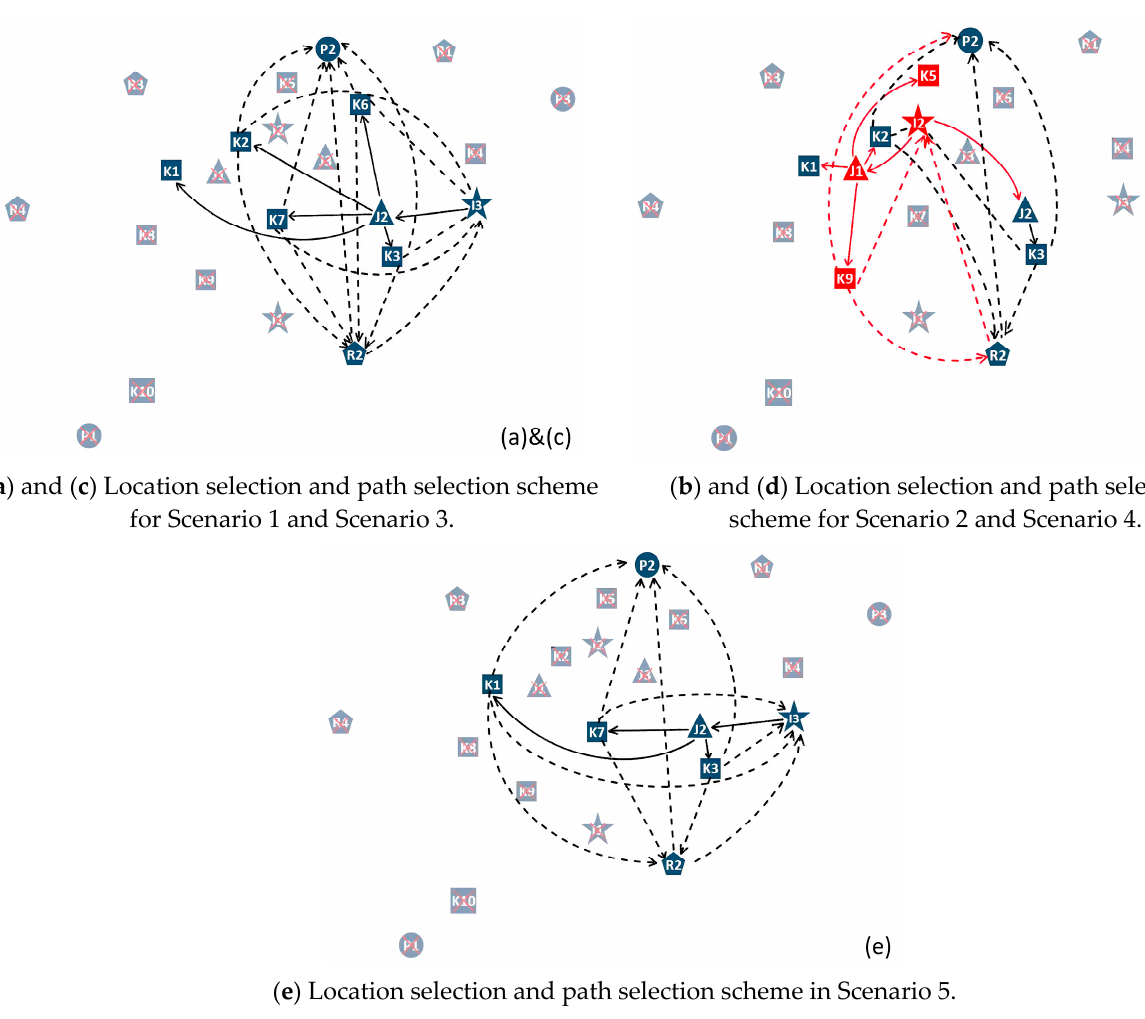
Figure 8. Location selection and path selection schemes in different scenarios.